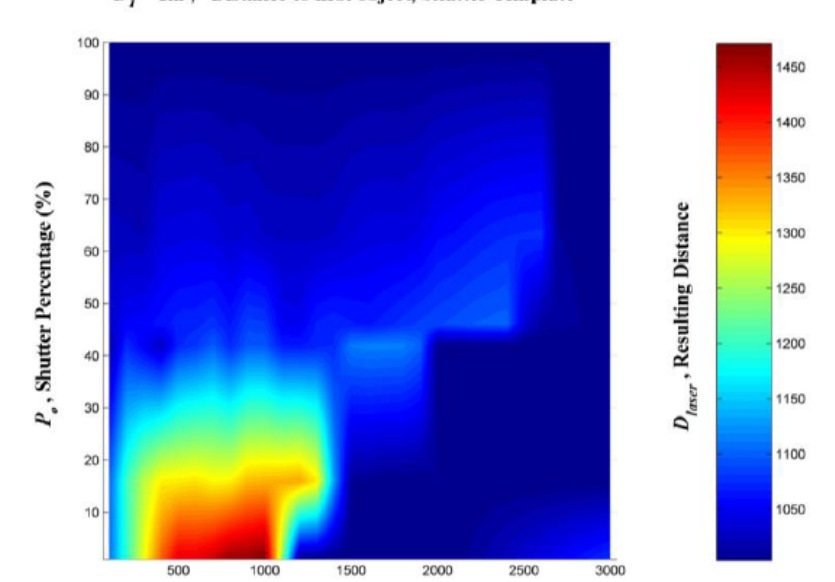
Figure 16. Graphic representation of the distance values (D the results of the progressive blockage of the beam at 90° with the shutter template at a ) of 1,000 mm from the sensor, with different values of D distance (D 1 0 and 3,000